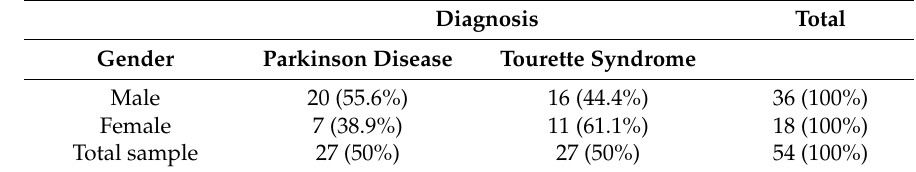
Table 3. Gender of the sample.